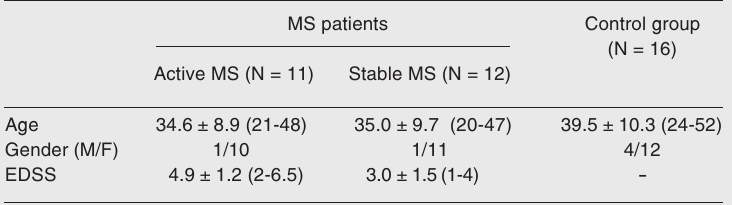
Figure 1. CXCL10 levels in cere- brospinal fluid (CSF) of patients with active multiple sclerosis (MS; N = 11), stable MS (N = 12) and control subjects (N = 16). *P < 0.05 compared to